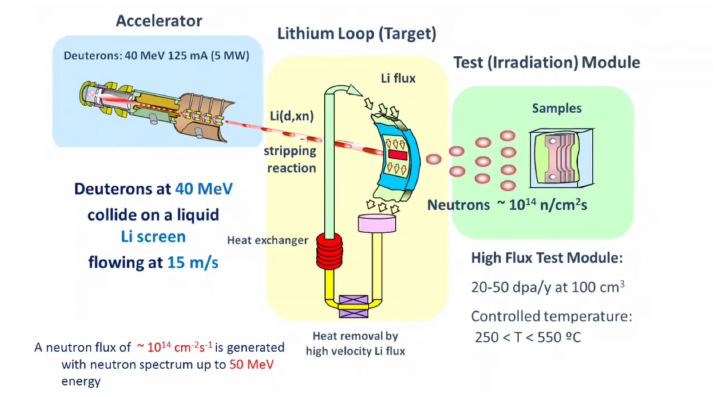
Figure 24. Process carried out in IFMIF-DONES. Reprinted from Ref.